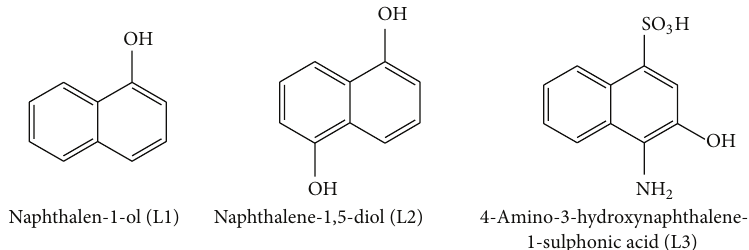
Scheme 1: The chemical structure of the studied naphthalene derivatives.